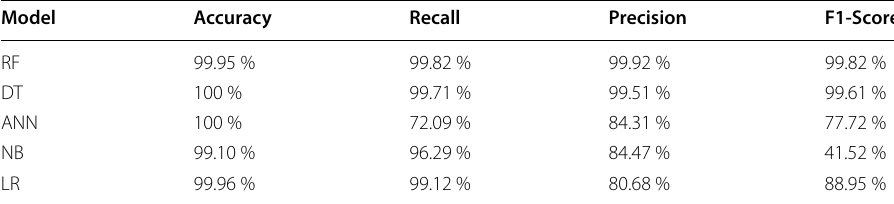
Table 11 Classification results for v 0 in Table